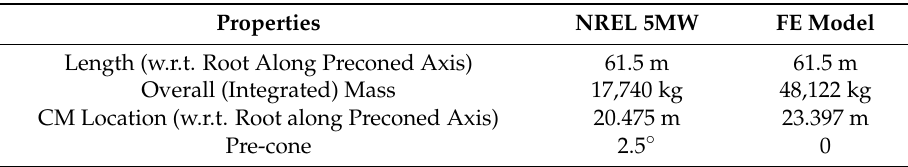
Table 3. Comparison of blade FE model and NREL 5MW baseline blade.